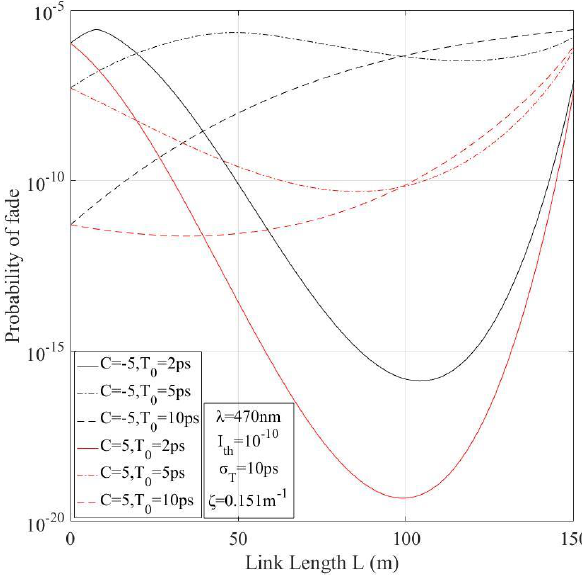
Figure 5. Probability of fade as a function of the propagation distance for various cases of input pulsewidth and chirp with fixed irradiance threshold; I th = 1 × 10 −10 and variance σ T = 10 ps.